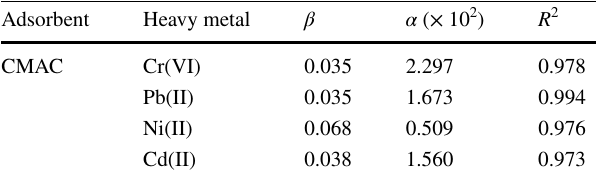
Table 7 Elovich’s rate